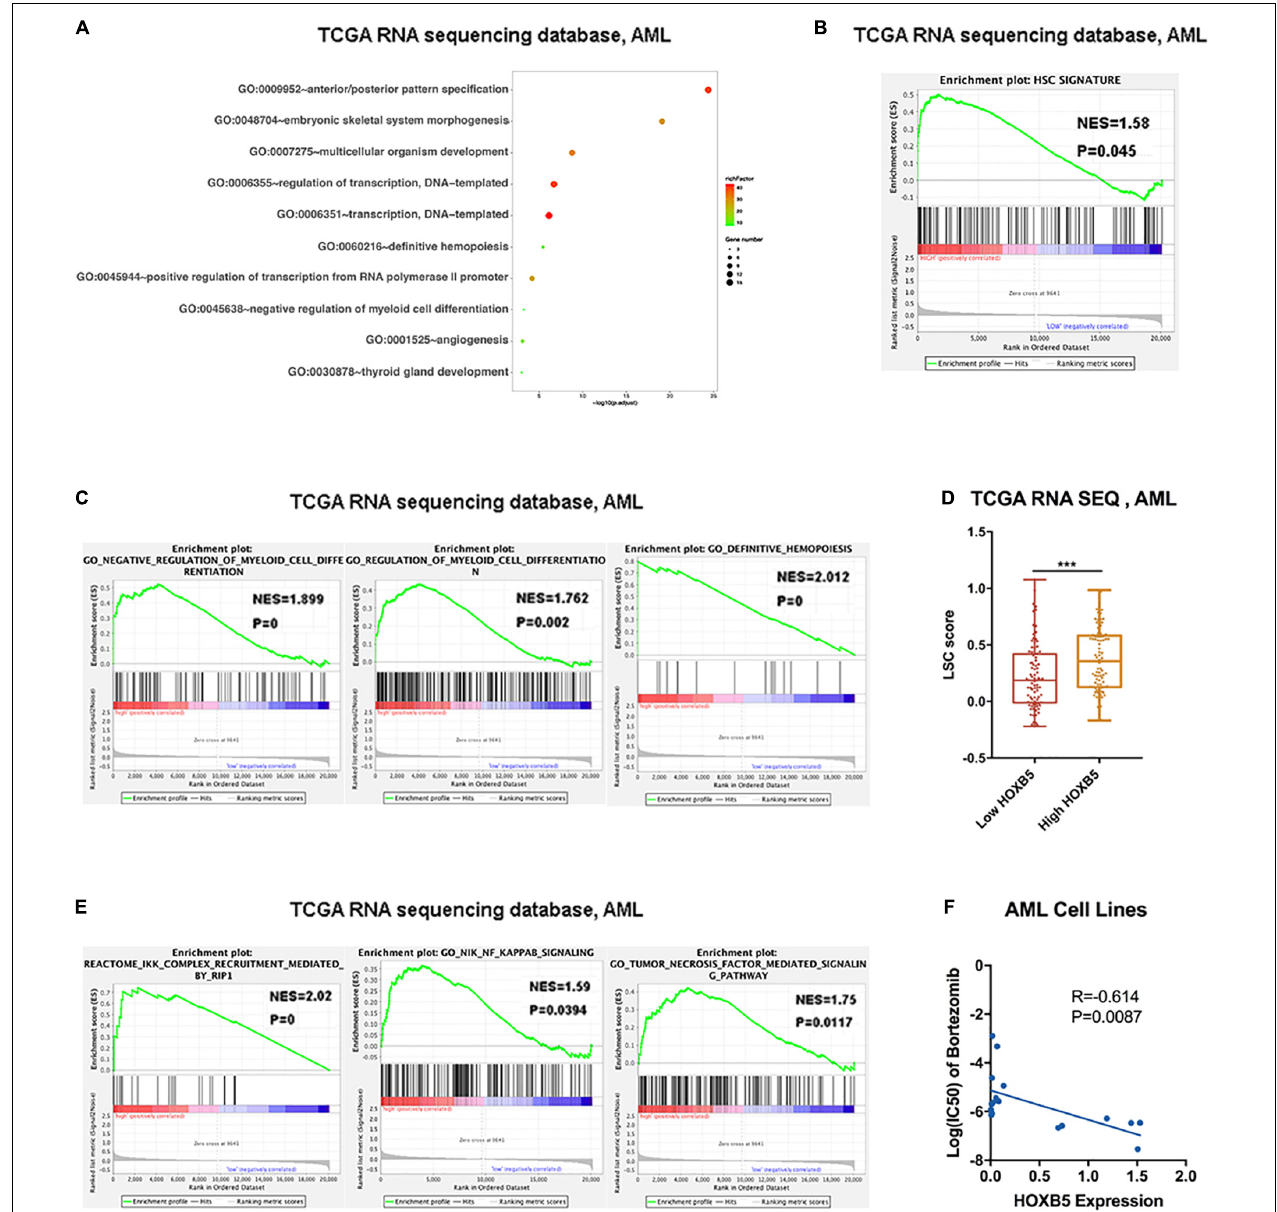
FIGURE 3 | Downstream function analysis. (A) GO analysis showing the top 10 functions associated with HOXB5 positive-correlated genes in AML. (B) The result of GSEA verified HOXB5 acted in the HSC signature. (C) The results of GSEA verified HOXB5 acted in regulation of myeloid cells differentiation. (D) The difference of LSC score classified by HOXB5 expression. (E) The results of GSEA verified HOXB5 acted in the TNF/NF- κ B pathway. (F) The correlation between HOXB5 expression and the IC50 of bortezomib in AML cell lines (with Pearson correlation analysis). *** P < 0.001.